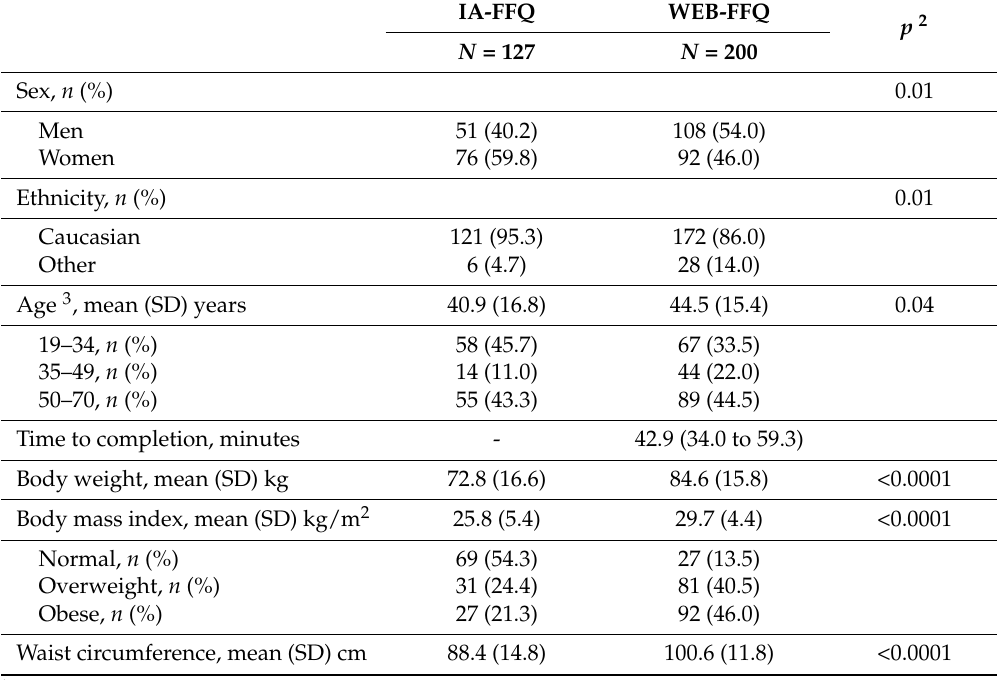
Table 1. Characteristics of the 327 men and women included in the analyses 1